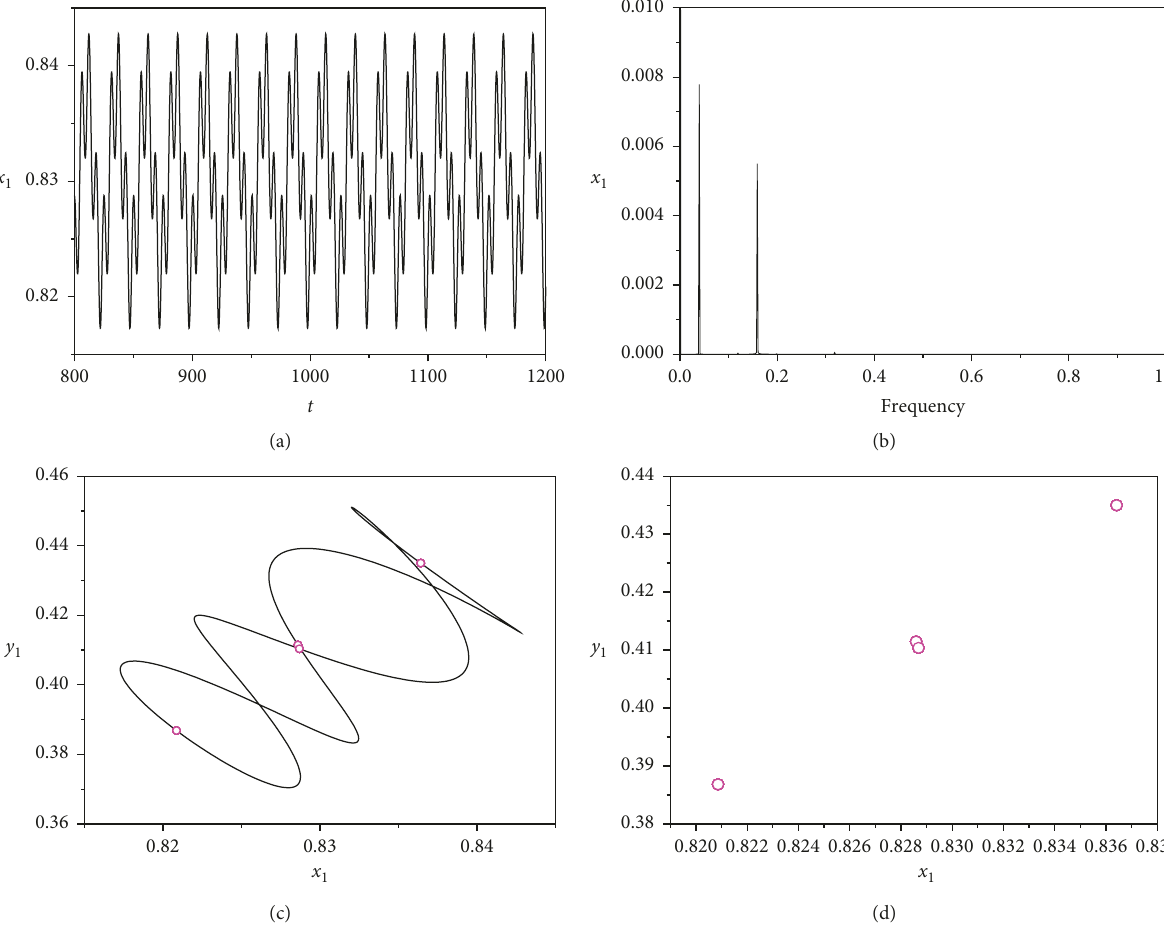
Figure 13: ω � 1.20 and η � 0.25: (a) displacement response; (b) frequency spectrum; (c) rotor orbit; (d) Poincar´e